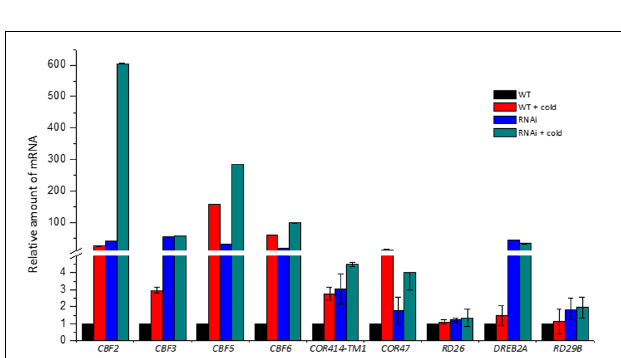
FIGURE 6 | Real-Time RT-PCR analysis of the cold-responsive genes in the WT and RNAi mutant with or without cold treatment. Leaves were harvested 24 h after a 4 ◦ C cold treatment. The expression level of each gene was normalized to that of BdGAPDH gene, and the expression level for each gene in the WT without cold treatment was set to 1.0. Error bars represent the standard deviation from independent